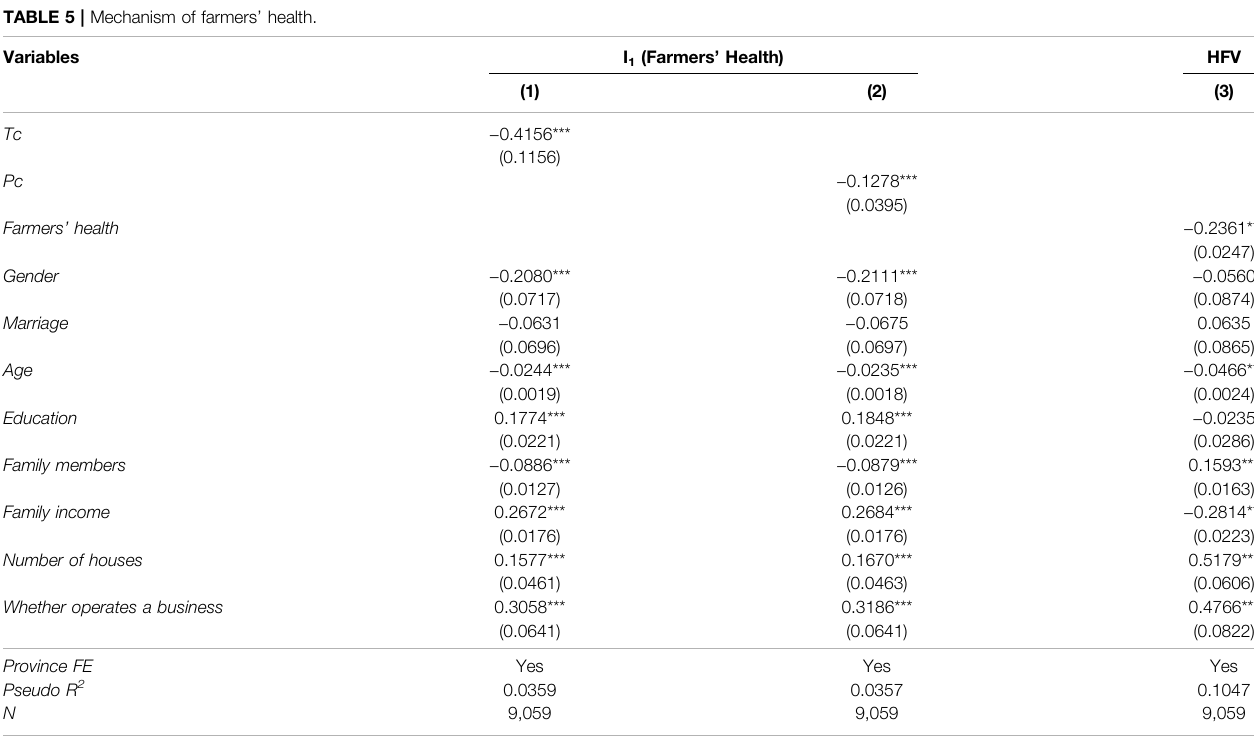
TABLE 5 | Mechanism of farmers ’